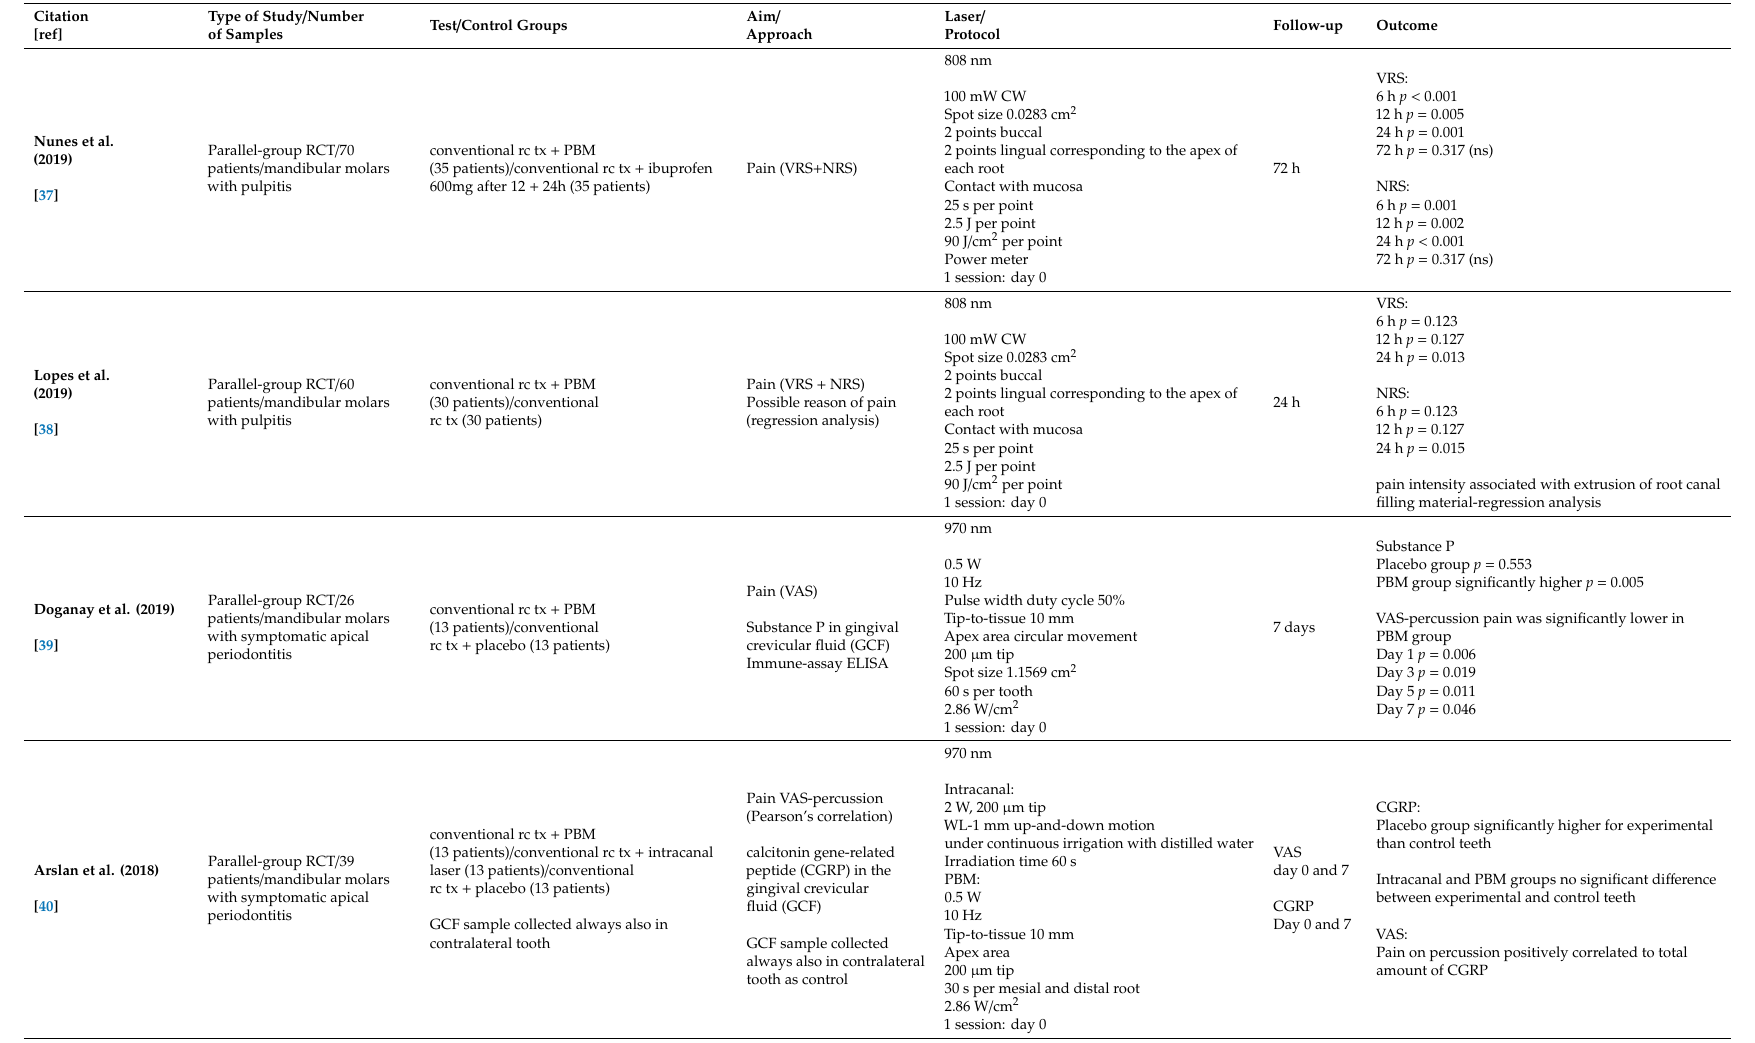
Table 3. Photobiomodulation (PBM) in endodontic